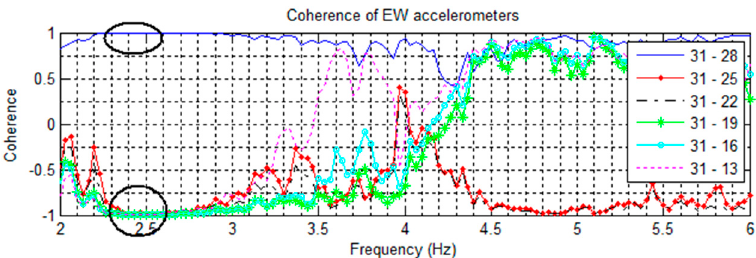
Figure 9. Coherences of EW oriented accelerometers paired against the floor 19 sensor. Note coherences at 2.51 Hz suggesting a cross-over point, and the coherence separation at 5.05 Hz.